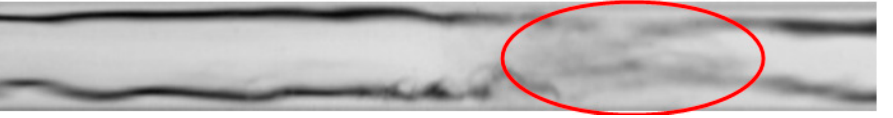
Figure 13. Formation of a slug structure during HFE7000 refrigerant condensation in a minichannel with an internal diameter d h = 0.8 mm ( G = 418 kg/m 2 s; x = 0.008; φ = 0.62; t s = 29 ◦